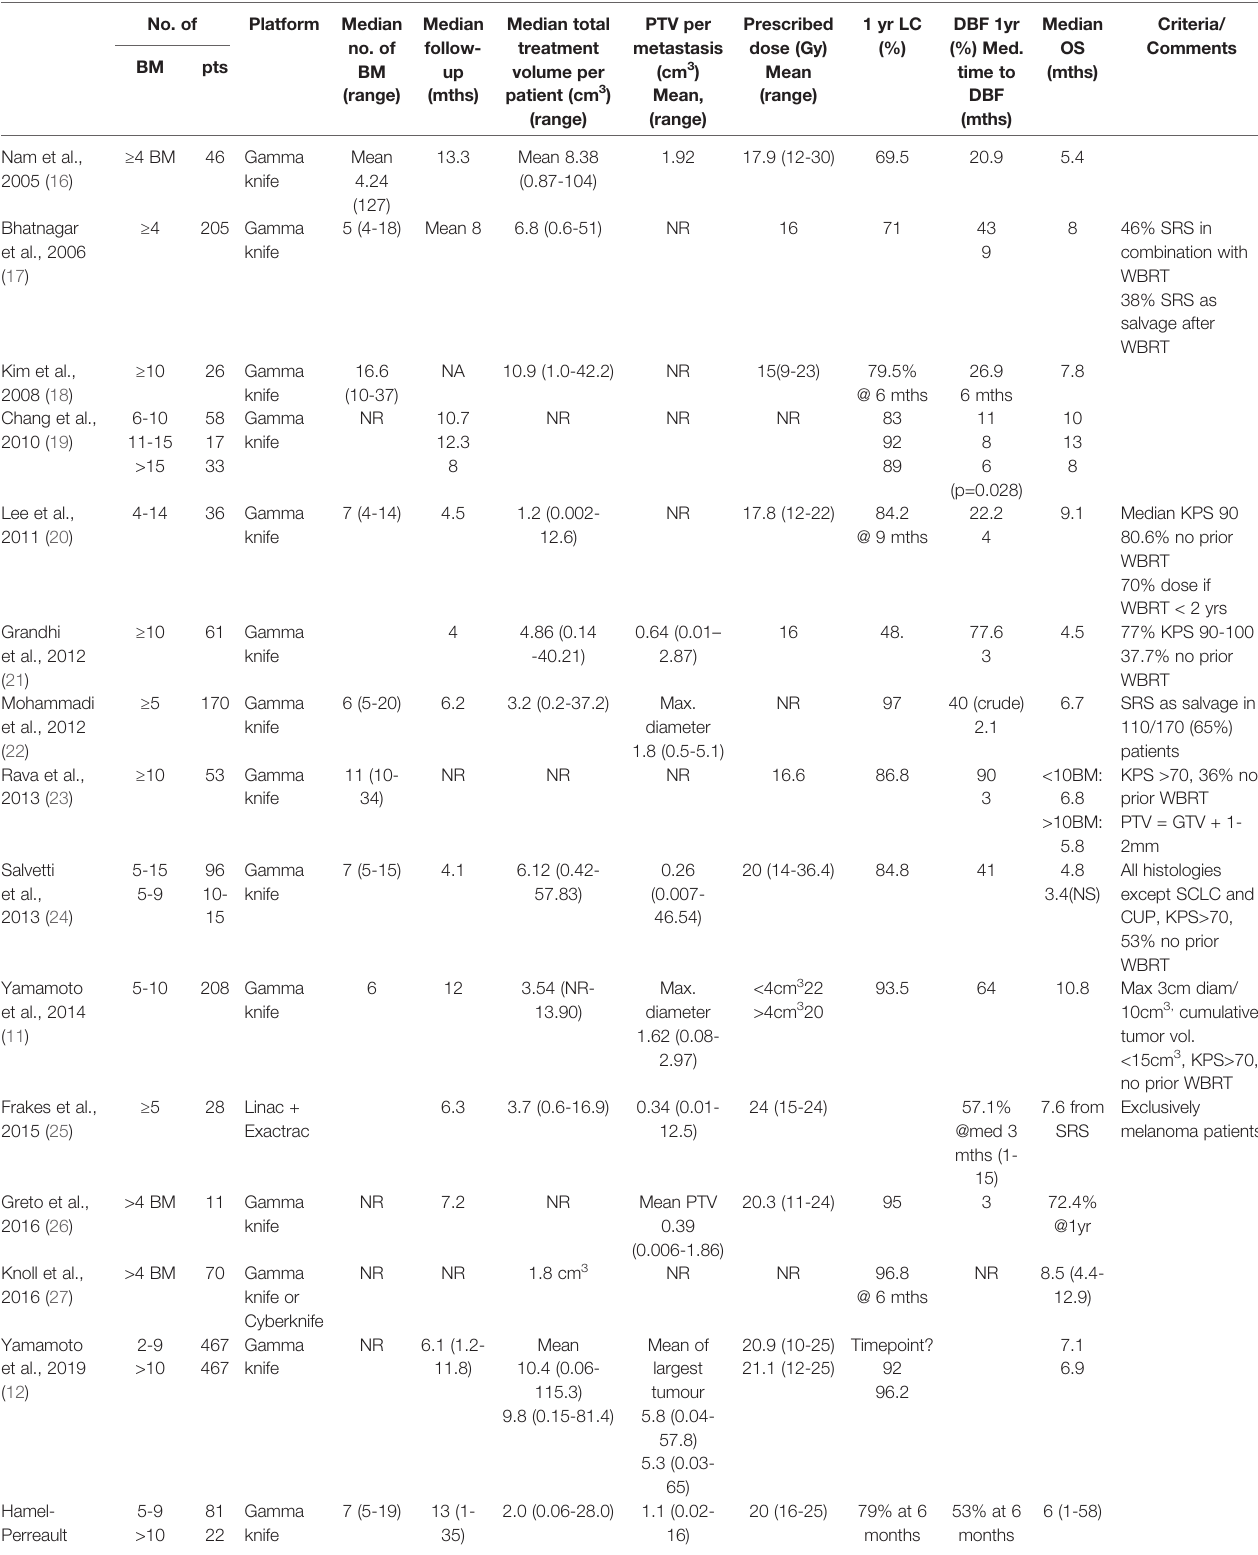
TABLE 4 | Summary of the literature pertaining to clinical outcomes after radiosurgery for four or more brain metastases. No.